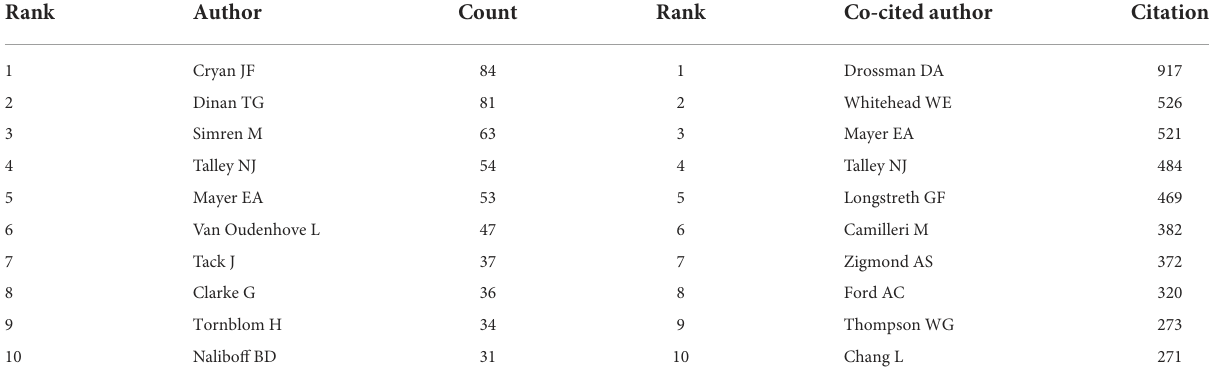
TABLE 4 Top 10 authors and co-cited authors of IBS and anxiety/depression